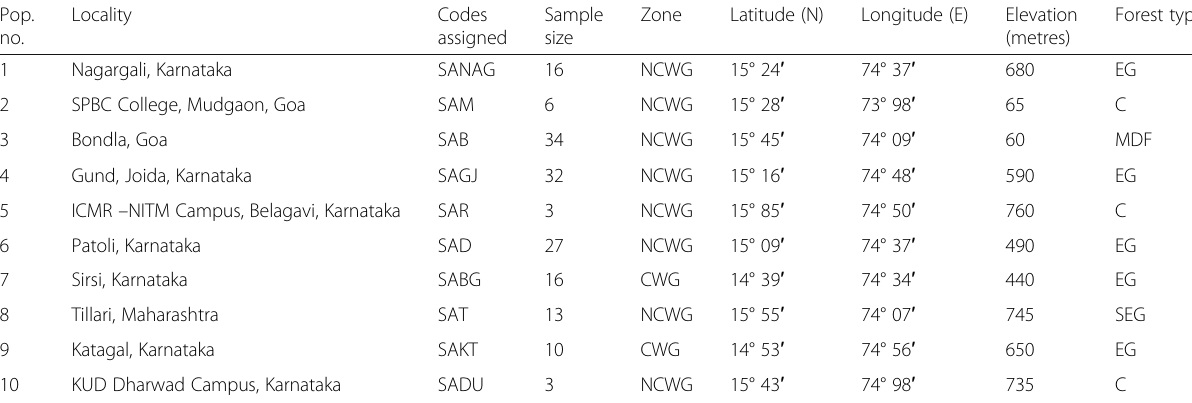
Table 1 Particulars and locations of S. asoca population (pops) samples collected Pop. no.